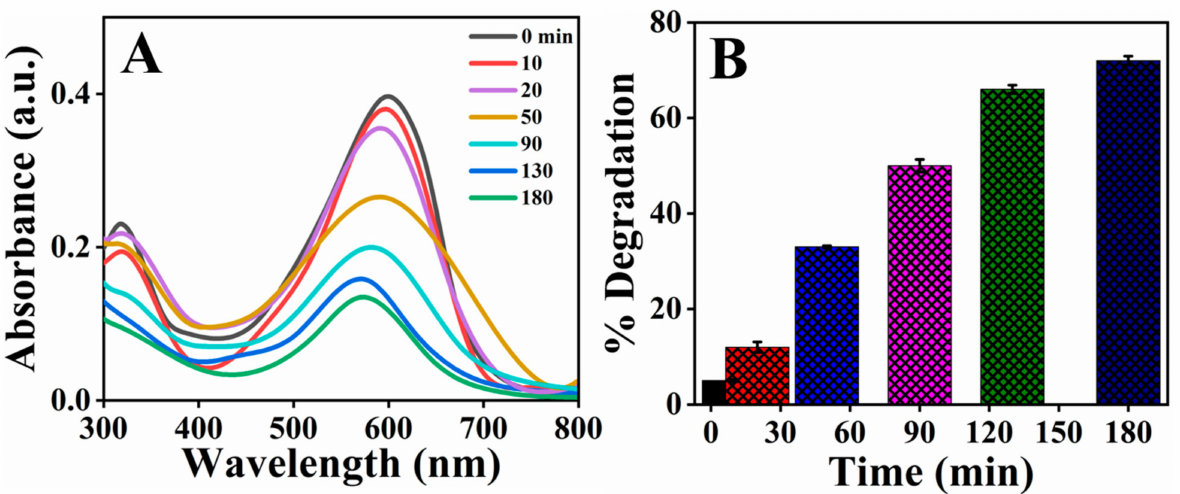
Figure 12. ( A ) Absorbance spectra of Direct Blue-15 (10 ppm) dye at different time intervals, ( B ) Percentage degradation of direct Blue-15 dye at different time